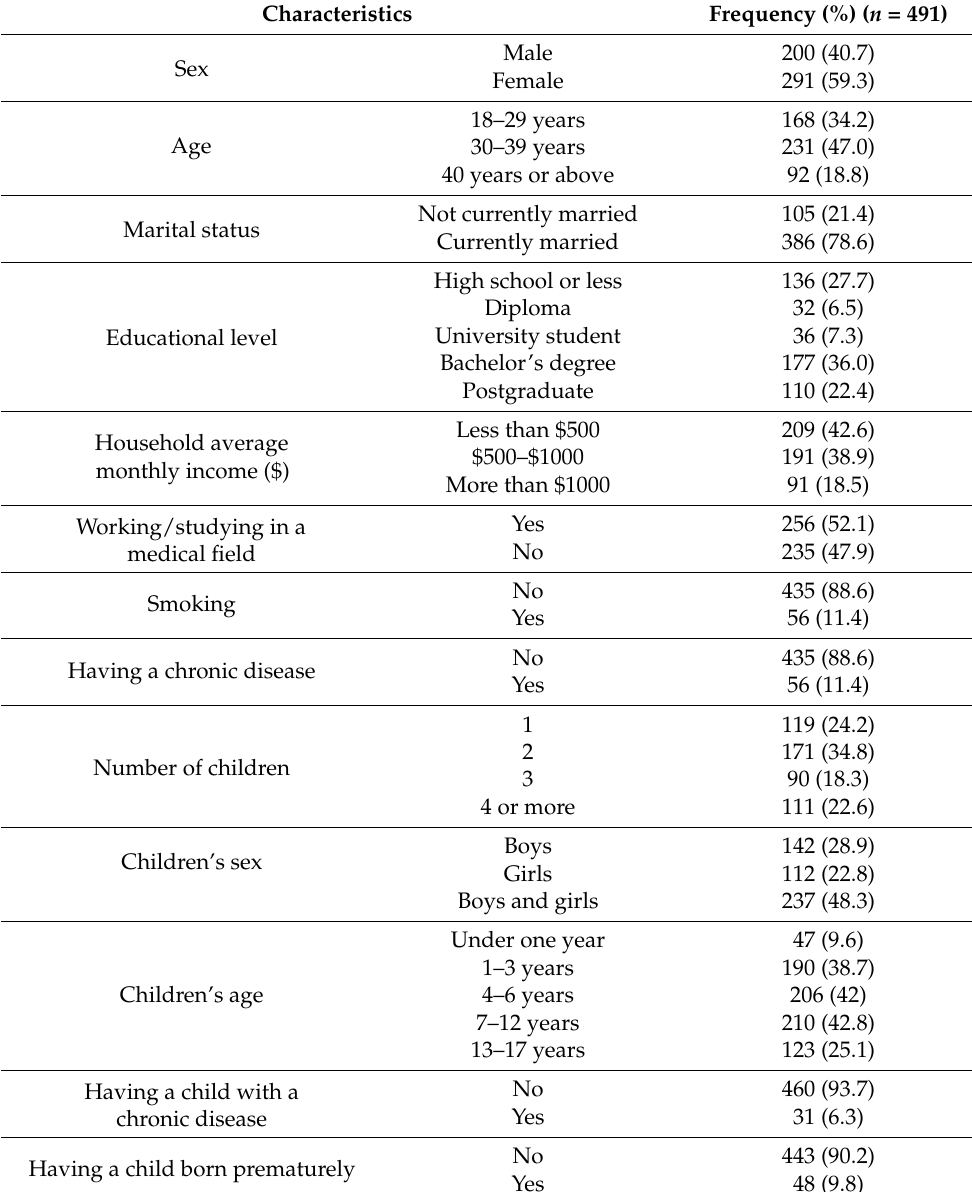
Table 1. Sociodemographic characteristics of the participants and their